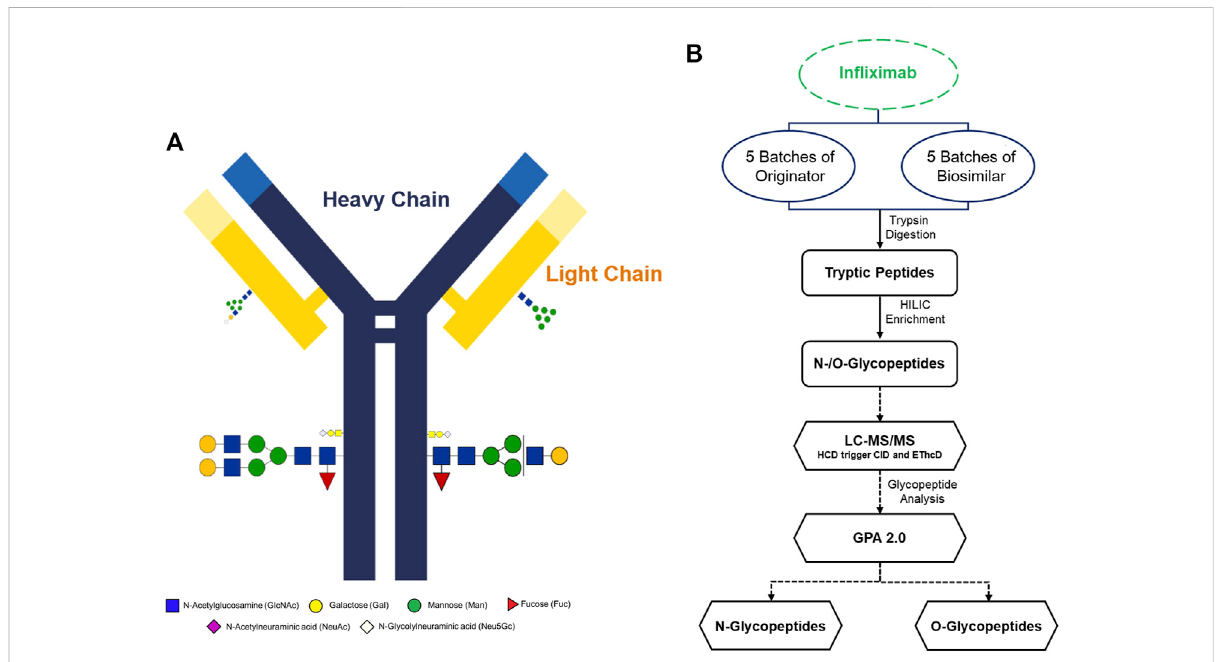
FIGURE 1 Overview of the experimental strategy and molecular structure of In fl iximab. (A) Schematic illustration of In fl iximab. The heavy chains are indicatedasbluelines,andthelightchainsareindicatedasyellowlines. (B) Aglycoproteomework fl owfortheanalysis ofN-andO-glycopeptides of In fl iximab.